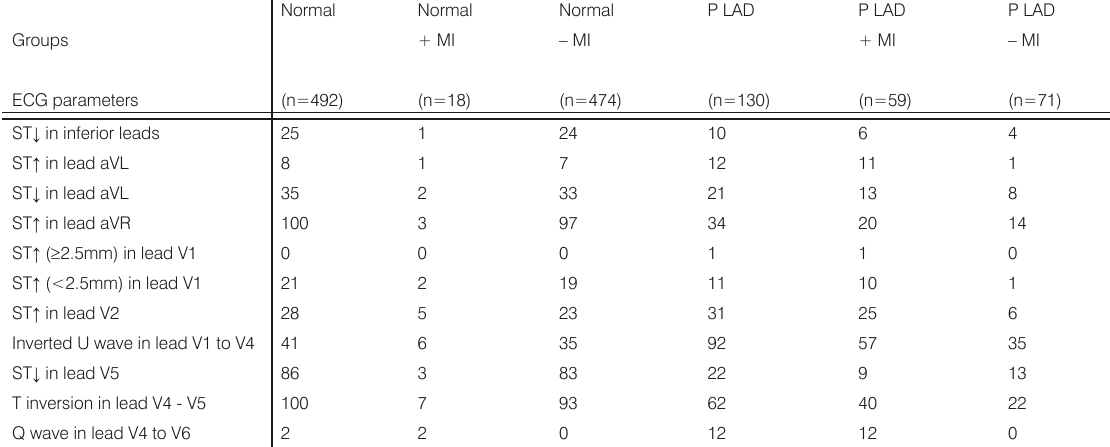
Table 2. Number of each ECG parameters in different